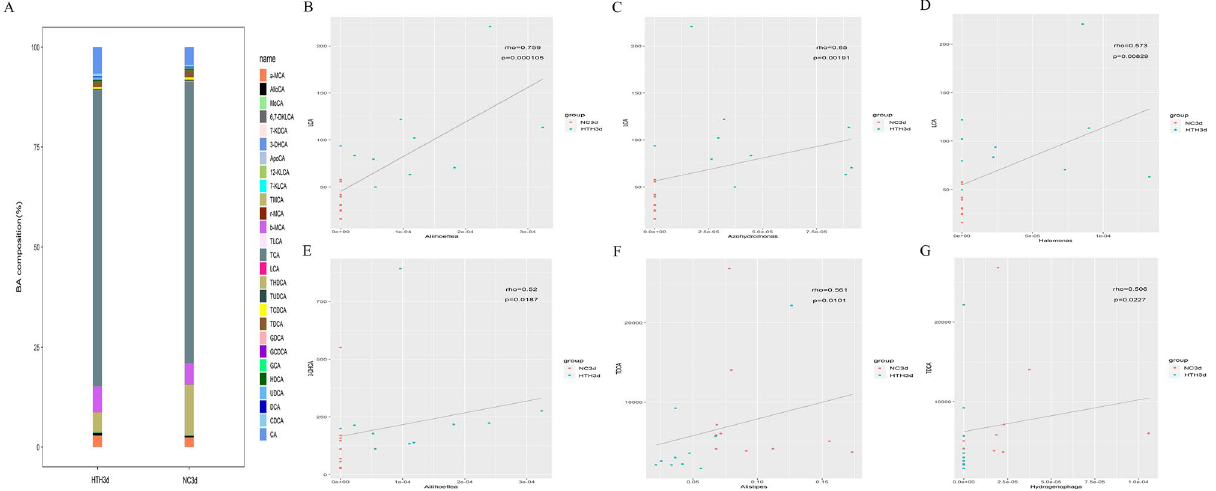
Figure 4. Generate a histogram of the composition of the bile acid pool based on the detection results of bile acids ( A ) to visually show the proportion of various bile acids and a higher proportion of bile acids. ( B – G ): The scatterplot illustrates the statistical correlation ( p < 0.05) between the changed relative abundance of intestinal bacteria in mice and altered mouse liver bile